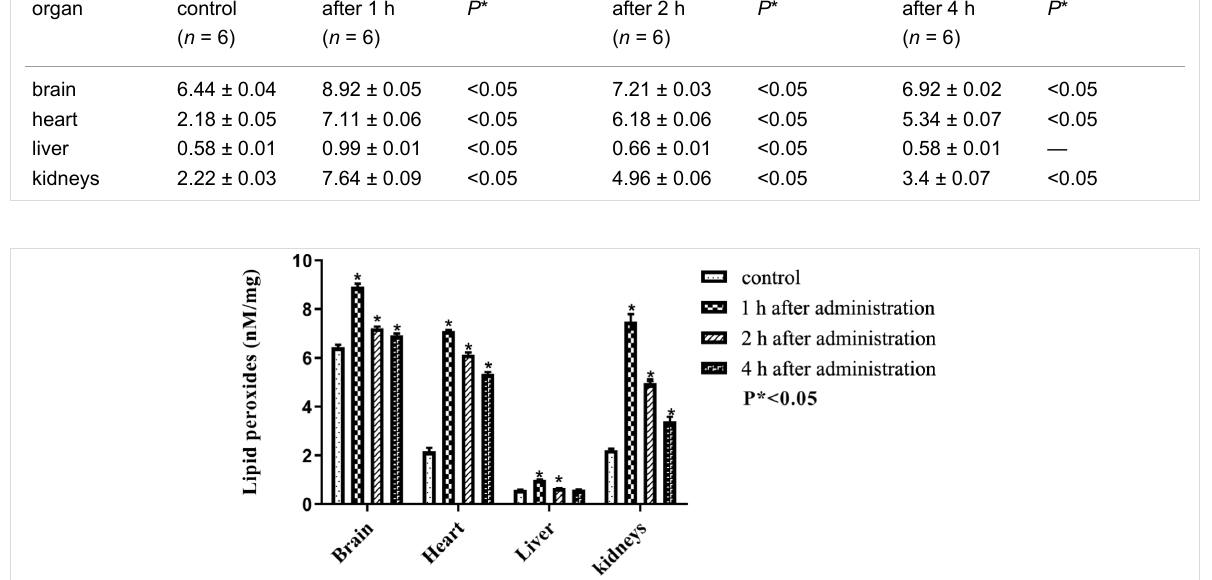
Table 2: Catalase activity normalised to the wet-tissue mass (U/mg) after administration of PEGylated nano-graphene oxide in different organs after different periods of time (mean ± standard deviation). organ